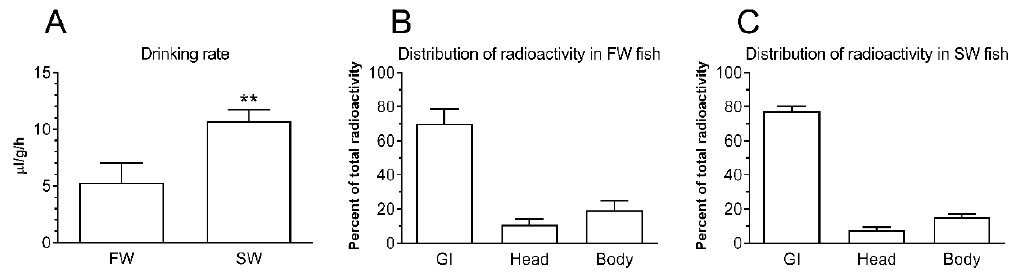
Figure 1. ( A ) Drinking rate ( μ L/g/h) in fresh water (FW) and seawater (SW)-acclimated medaka estimated by radioactivity in the entire gastrointestinal tract after incubation in 51-Cr-EDTA traced FW or SW for 3 h followed by rinsing in clean water for 1 h. ** p < 0.01. In ( B ) (FW) and ( C ) (SW), the radioactivity content of the gastrointestinal tract (GI, imbibed) is compared to radioactivity absorbed to the head and remaining body parts.